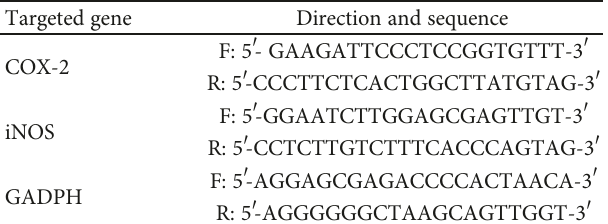
Table 1: Primer sequences. Targeted